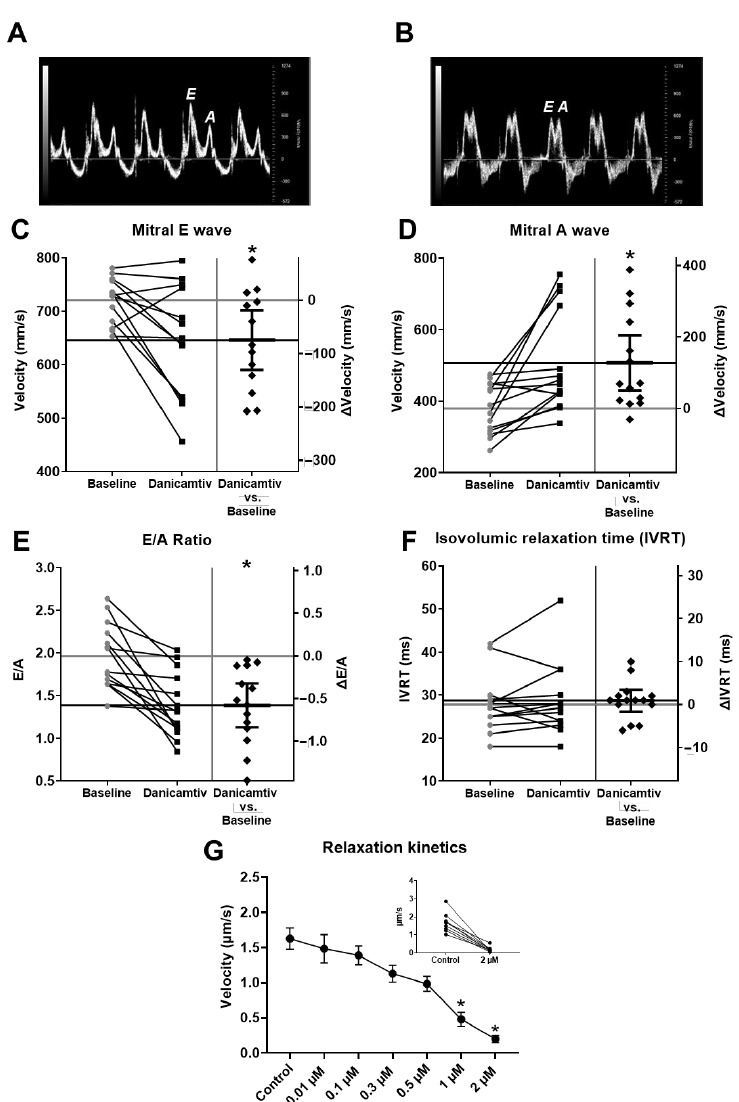
Figure 5. Danicamtiv impaired LV diastolic function and relaxation kinetics. Pulsed-wave